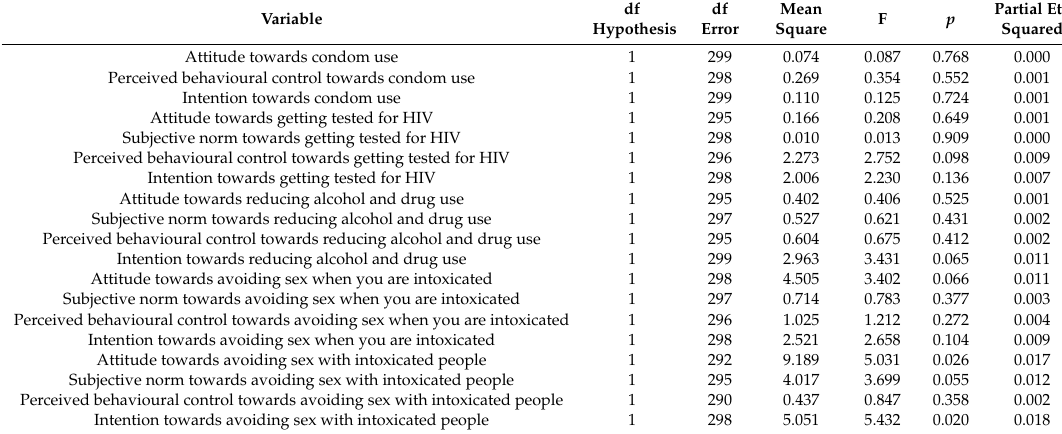
Table 4. Repeated Measures Within-Subject E ff ect, Greenhouse–Geisser (time*group), Study 1 experiment vs control.